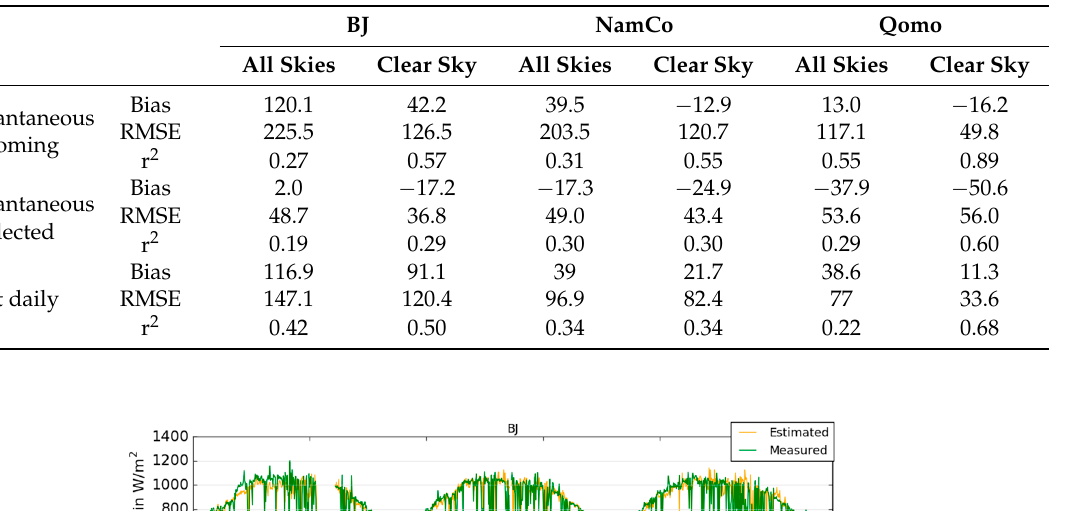
Table 3. Solar radiative flux validation statistics for instantaneous incident fluxes, reflected fluxes, and daily net solar radiation. The bias (W ¨ m ´ 2 ), root-mean-square-error (RMSE, W ¨ m ´ 2 ) and r 2 are provided for all and clear skies conditions, at BJ, Qomo, and NamCo stations for the entire time series.